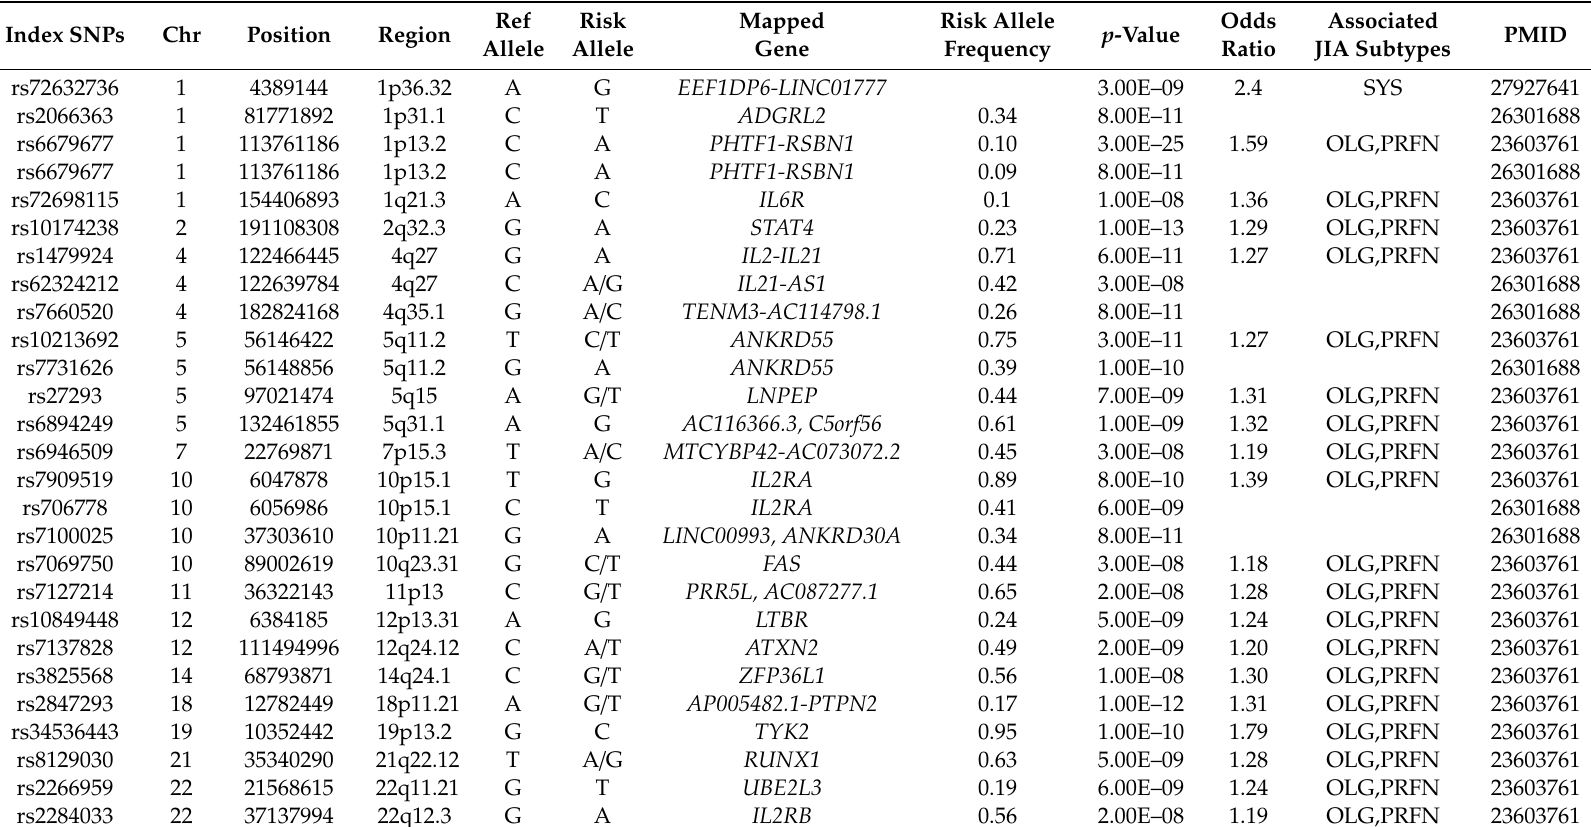
Table 3. Genome-wide significant loci (non-HLA) associated with JIA summarized in GWAS Catalog (https: // www.ebi.ac.uk / gwas / ). JIA associated SNPs listed in GWAS catalog were clumped into independent loci based on the linkage disequilibrium and distance between